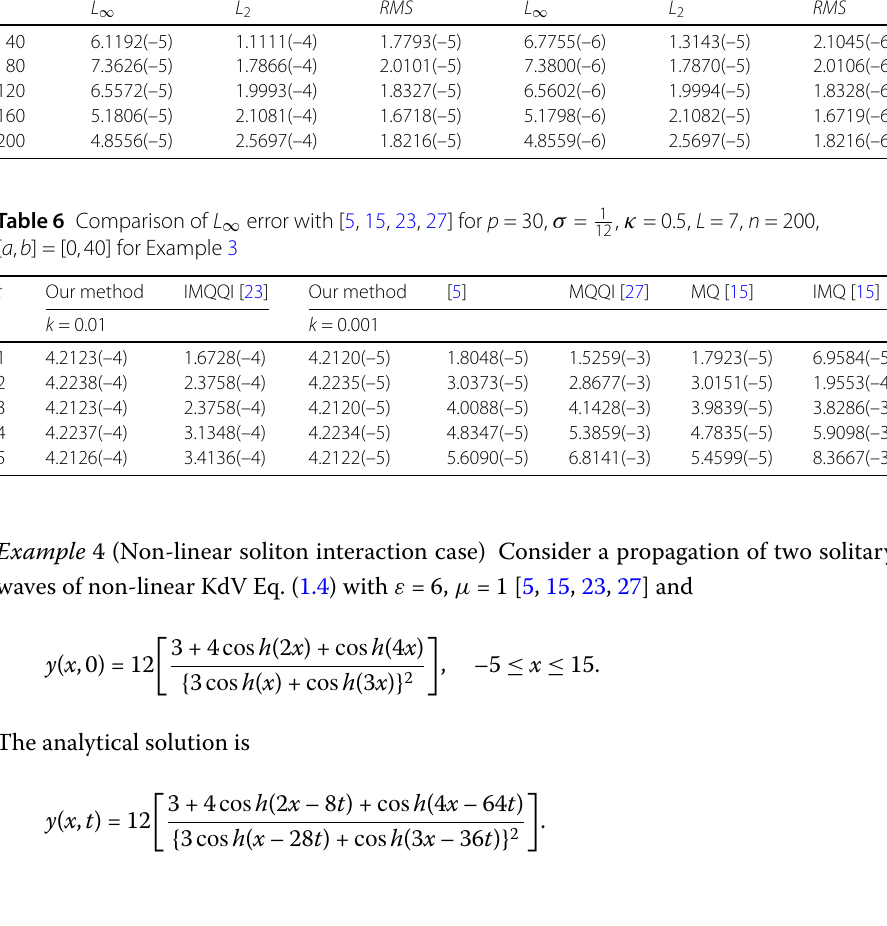
Table 5 L ∞ , L 2 and RMS errors for p = 25, σ = 1